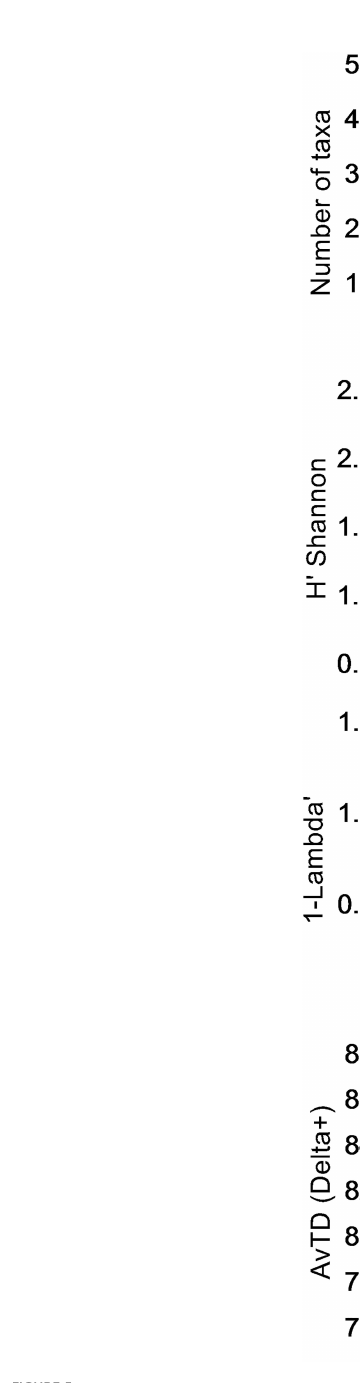
FIGURE 5 Diversity patterns by zones from stations covering from 0 to 700 m with the Mesopelagos net. Number of taxa, H ’ Shannon-Wiener diversity index, 1-Lambda: Simpson Equitability index and AvTD (Delta+) index (Average Taxonomic Distinctness). (B: Balears, A: Alboran, C: Cadiz, L: Lisboa, G: Galicia). Different numbers indicate signi fi cant differences in mean values means (ANOSIM, p <